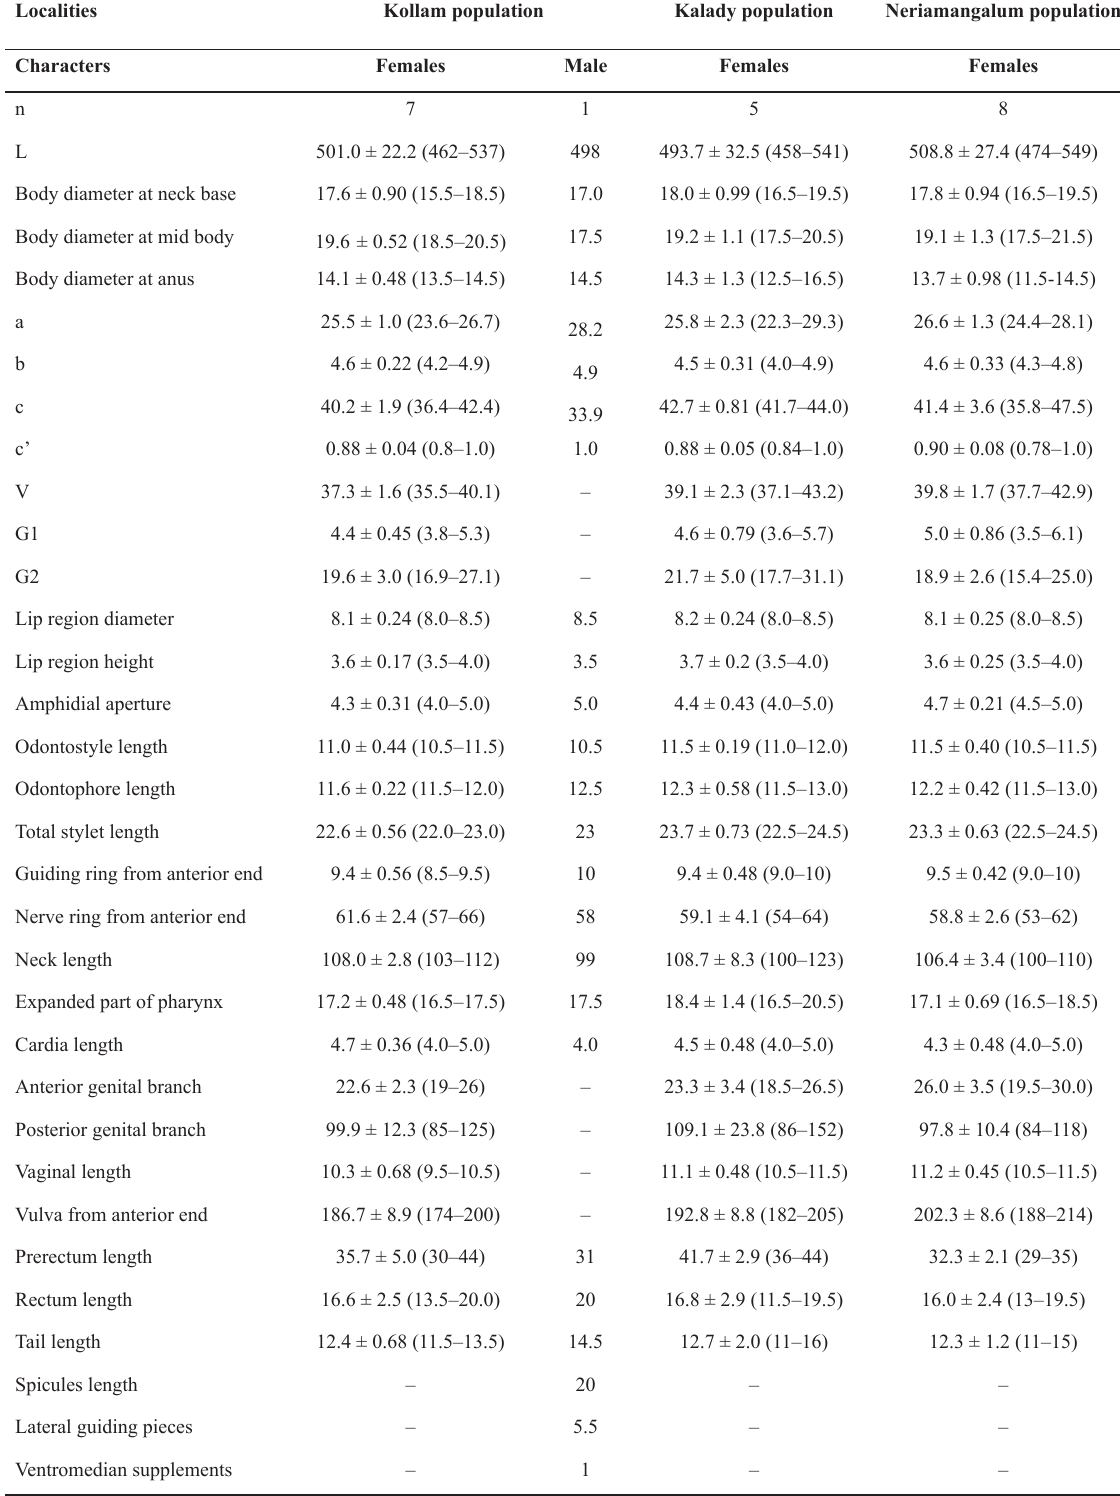
Table 1. Measurements of Basirotyleptus basiri Jairajpuri, 1964. All measurements are in μm and in the form: mean ± s.d.